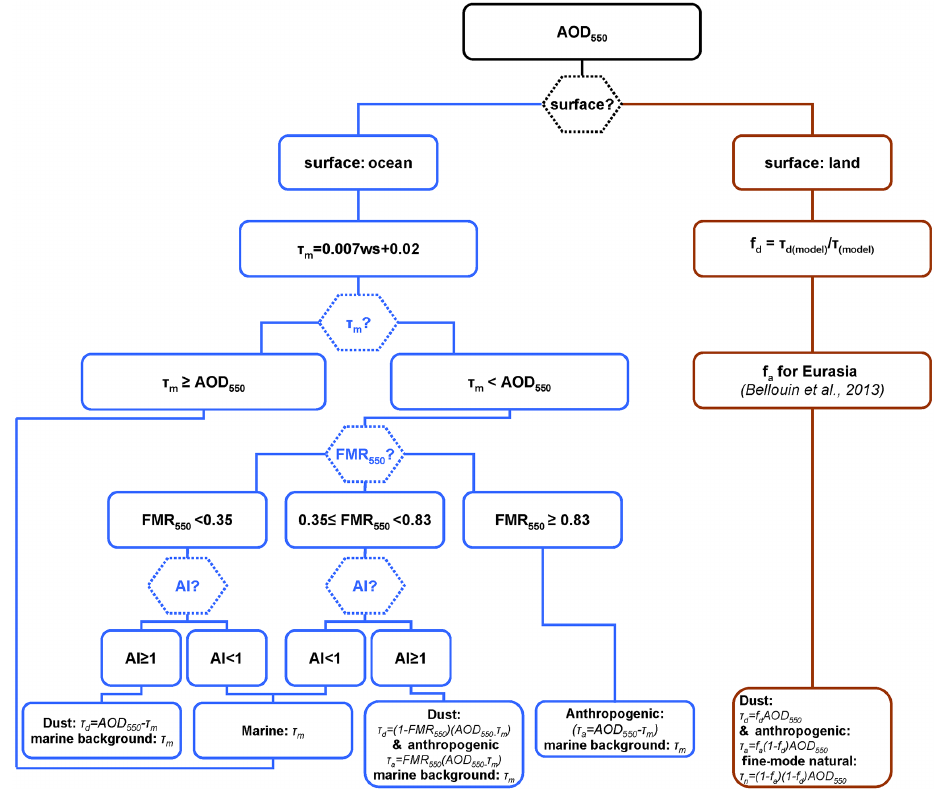
Figure 2. Flowchart with the methodology followed for the calculation of the anthropogenic aerosol, dust and marine aerosol optical depths ( τ a , τ d and τ m ) over the sea (blue color) and the anthropogenic aerosol, dust and fine-mode natural aerosol optical depths ( τ a , τ d and τ n ) over land (brown